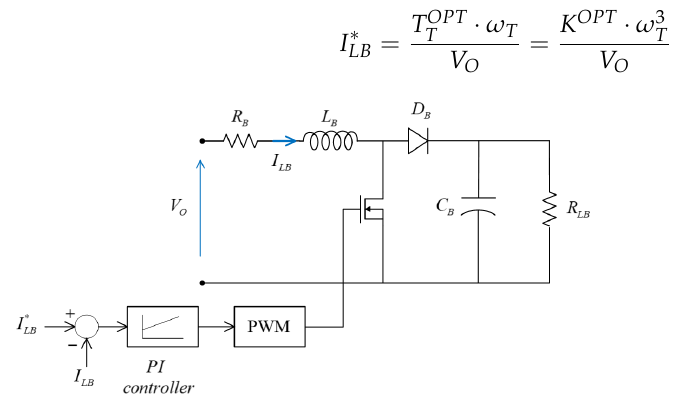
Figure 5. Scheme of one–level boost converter current-mode